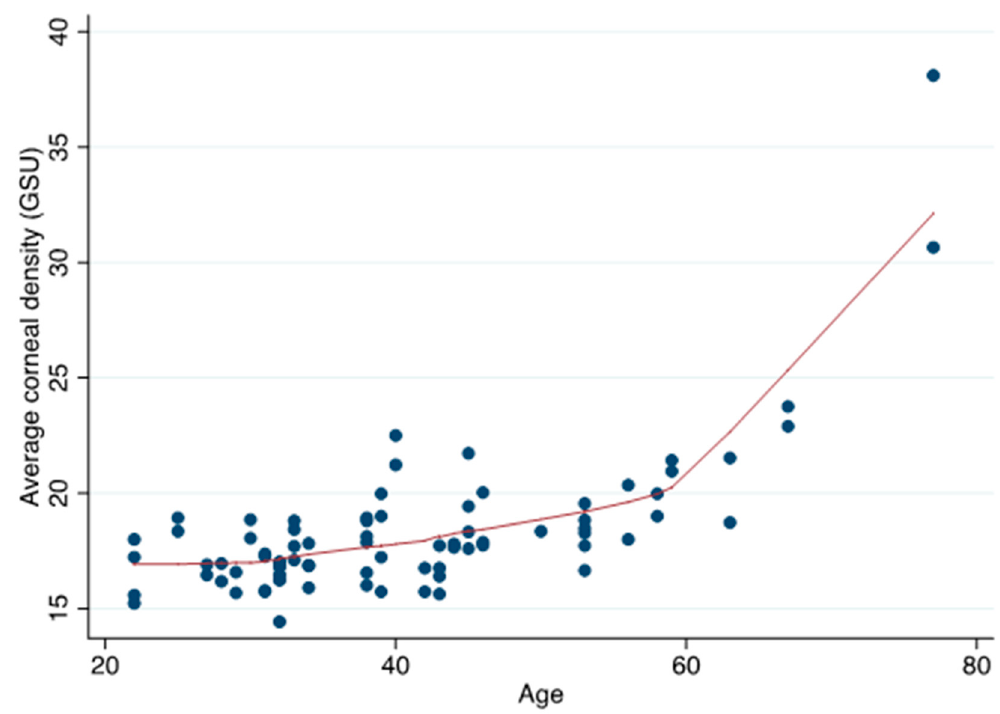
Figure 3. Scatter plot showing the relationship between age and average corneal densitometry (GSU).